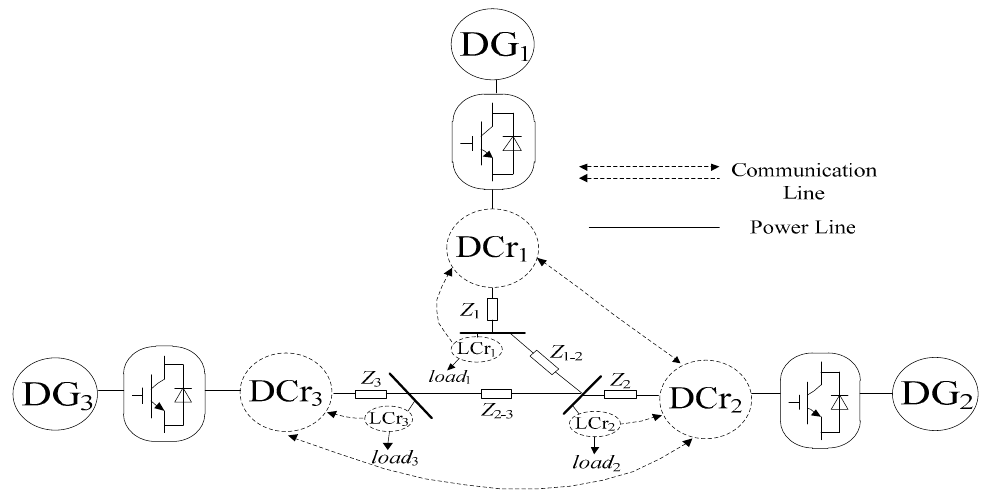
Figure 5. Structure of distributed secondary power optimization control based on the improved droop control strategy.